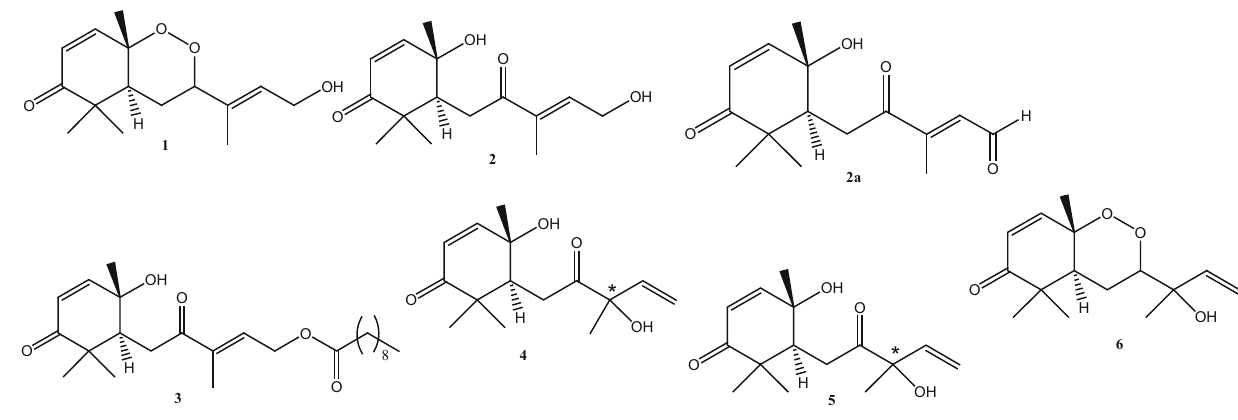
Fig. 2 Structures of